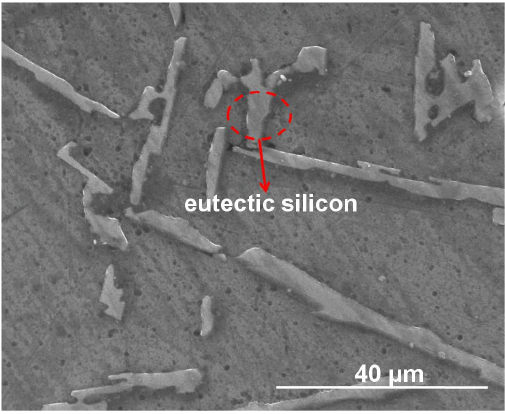
Figure 7. Cross-section morphology of as-cast ZL101 alloy.